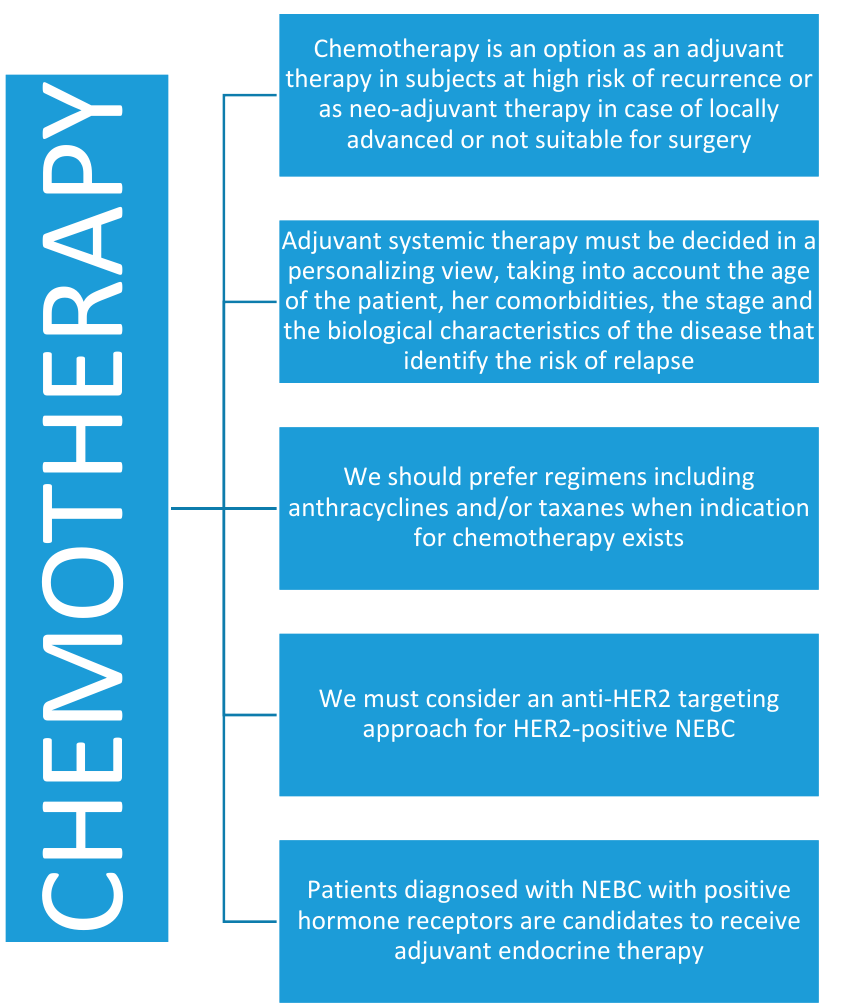
Figure 6. Chemotherapy in neuroendocrine breast cancer